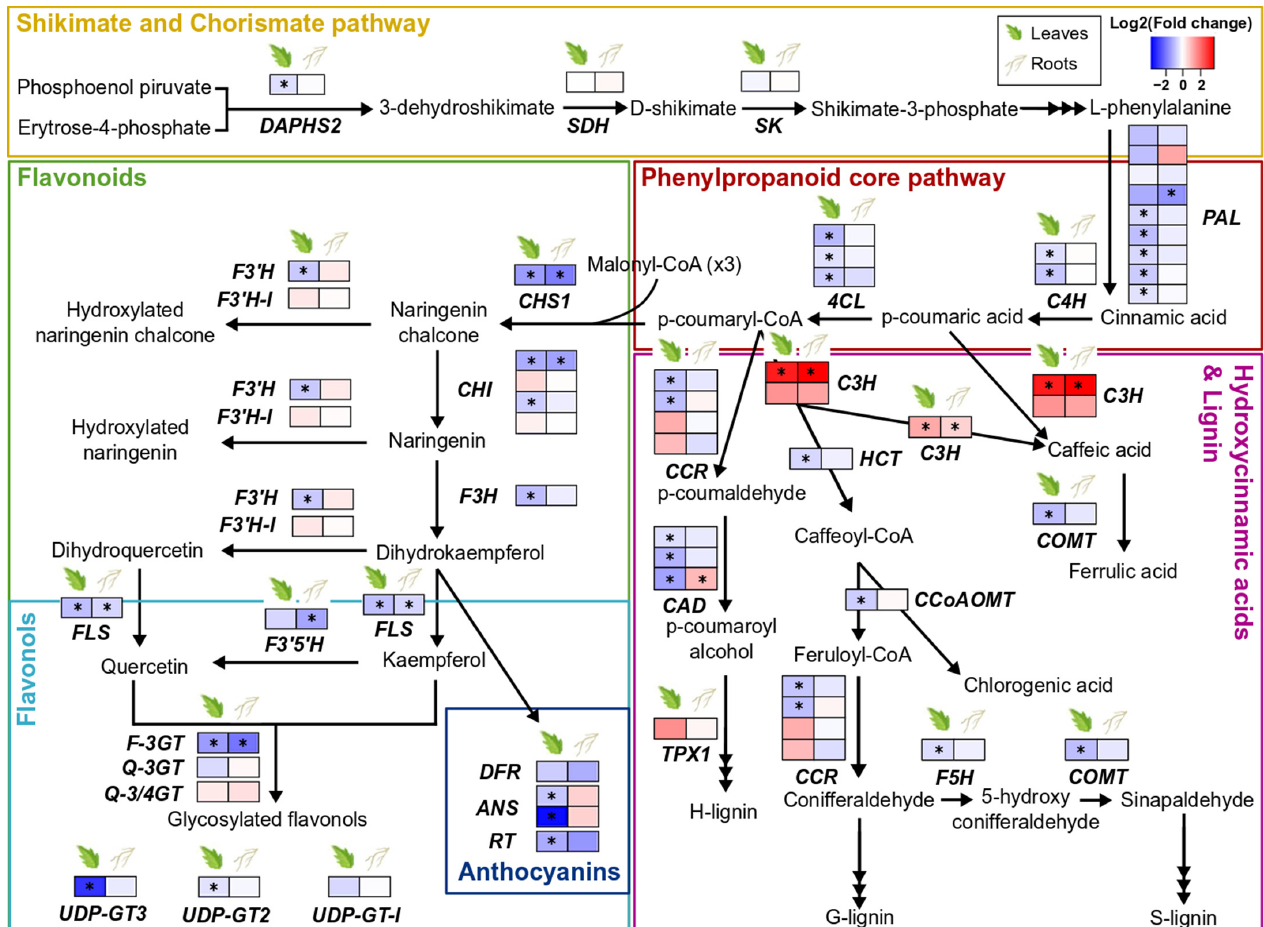
Figure 3. Changes in gene expression of phenylpropanoid biosynthetic pathways due to S. indica -colonisation in tomato leaves and roots. Key genes involved in the biosynthesis of shikimate and chorismate, flavonoids, flavonols, anthocyanins, hydroxycinnamic acids, and lignin are shown here. Changes in gene expression between tissues from inoculated plants and tissues from endophyte-free plants are represented as log 2 of the fold change in the form of a heatmap. Asterisks (*) indicate FDR-corrected p ≤ 0.05. DAHPS2, DAHP synthase 2; SDH, shikimate 5-dehydrogenase; SK, shikimate kinase; PAL, phenylalanine ammonia lyase; C4H, cinnamate 4-hydroxylase; 4CL, 4-coumarate:CoA ligase; CHS1, chalcone syn- thase 1; F3 ′ H, flavonoid-3 ′ -hydroxylase; F3 ′ H-l, flavonoid-3 ′ -hydroxylase-like; CHI, chalcone isomerase; F3H, flavanone- 3-hydroxylase; FLS, flavonol synthase; F3 ′ 5 ′ H, flavonoid-3 ′ 5 ′ -hydroxylase; F-3GT, flavonol 3-glycosyltransferase; Q-3GT, quercetin 3-glycosyltransferase; Q-3/4GT, quercetin 3/4-glycosyltransferase; UDP-GT3, UDP-glycosyltransferase 3; UDP- GT2, UDP-glycosyltransferase 2; UDP-GT-l, UDP-glycosyltransferase-like; DFR, dihydroflavonol reductase; ANS,